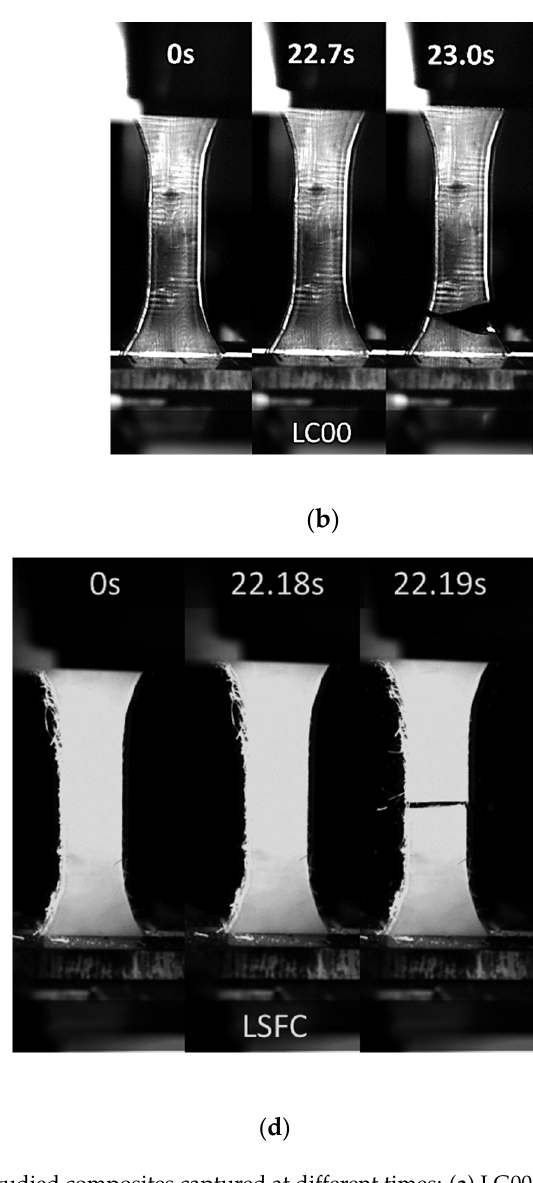
Table 4. Tensile properties for all studied composites.